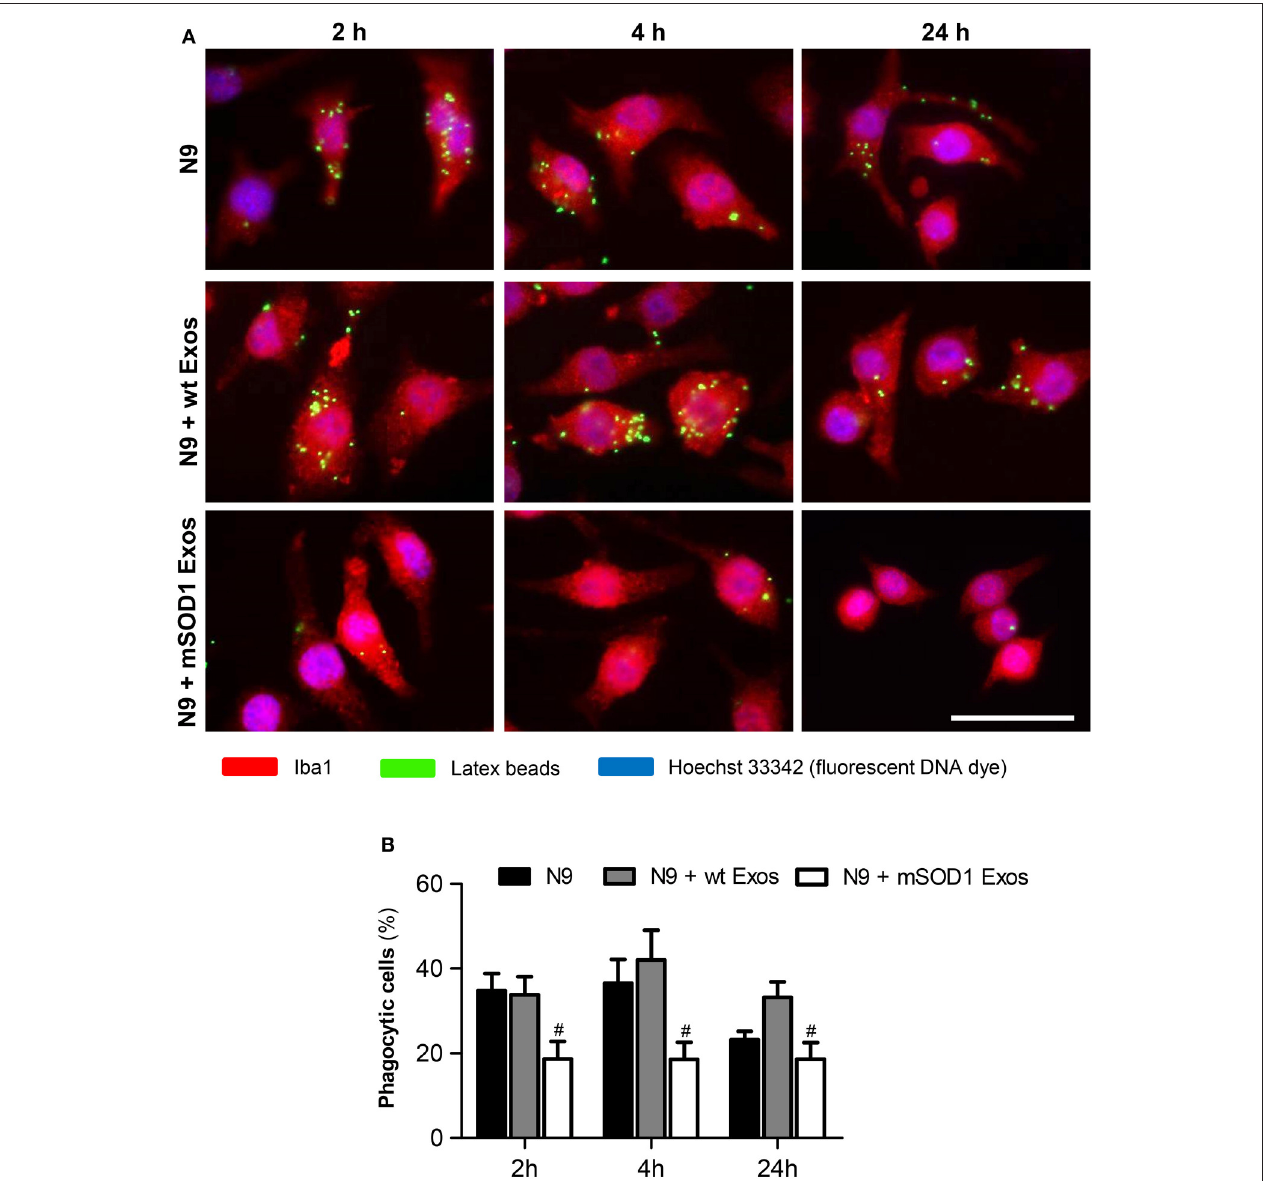
FIGURE 8 | Exosomes from NSC-34 motor neurons (MNs) mutated in G93A (mSOD1) determine a sustained and marked decrease in the N9 microglia phagocytic ability. N9 microglial cells were incubated for 2, 4, and 24 h with exosomes (Exos) from wild-type (wt) NSC-34 MNs and mSOD1 NSC-34 MNs (N9 + wt Exos and N9 + mSOD1 Exos, respectively), as indicated in methods. Non-treated cells were considered as control. (A) Representative results of one experiment, showing engulfed latex beads (in green) by the Iba1 stained (in red) microglia with nuclei labeled by Hoechst dye (in blue). (B) Results are expressed as percentage of cells, relatively to the total number of microglia, showing ingested beads. Results are mean ( ± SEM) from eight independent experiments. Differences between the three different groups at each time point were obtained by one-way ANOVA followed by Bonferroni post-hoc correction. # p < 0.05 vs. exosomes from wt MNs. Scale bar represents 40 µ